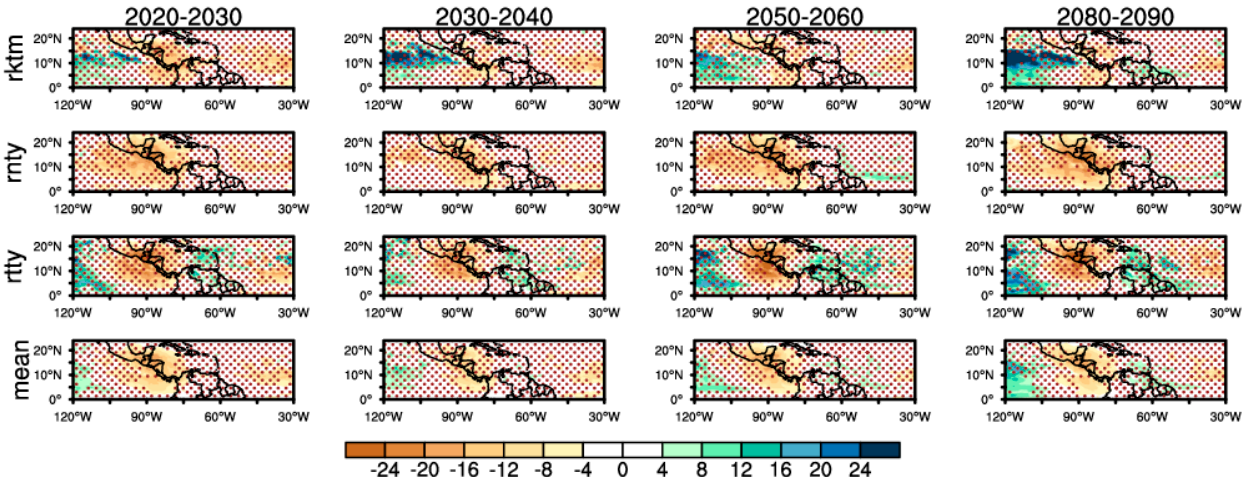
Figure 9. Mean annual percent change (%) in the contribution of Easterly Waves to summer precipitation in the future ensemble runs with respect to the reference period (1990–2000). The dotted regions indicate a 95% significance level applying the Kolmogorov–Smirnov two-sample test.